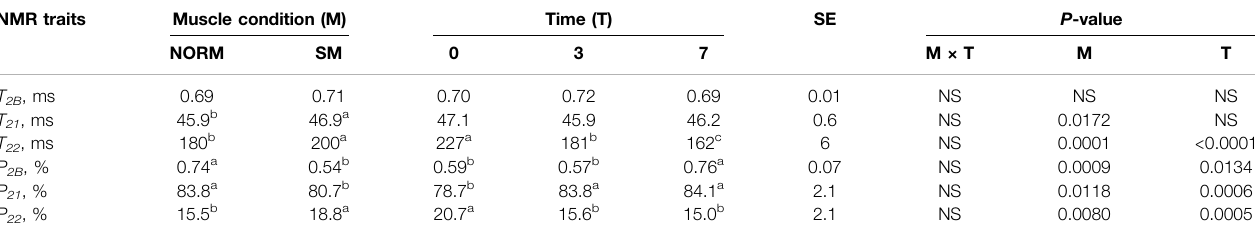
TABLE4| TimeDomain-NuclearMagneticResonancetraitsofbroilerbreastmeataccordingtomusclecondition(M — normal,NORM;SpaghettiMeat,SM)andpostmortem time (T — 0, 3, 7 days). NMR